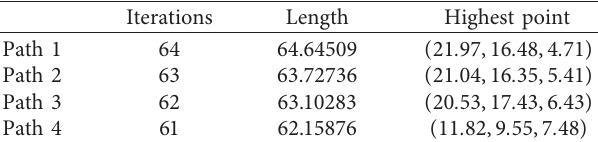
Table 4: The different saturation λ